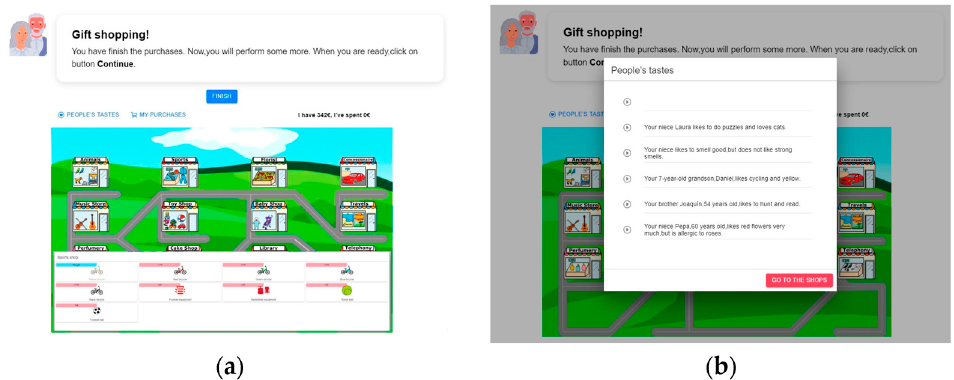
Figure 1. Example of exercise Gifts Purchase . It serves to improve planning skills (establishing goals, controlling implementation, and measuring results). The screen shows a shopping area, and the participant must buy a series of gifts for other people on account of each person’s listed preferences and within a limited budget. ( a ) is a screenshot of the main scenario, the stores that are in the city, along with an example of products that can be purchased in the sports store. ( b ) is an example of the people to buy a gift for and their tastes.